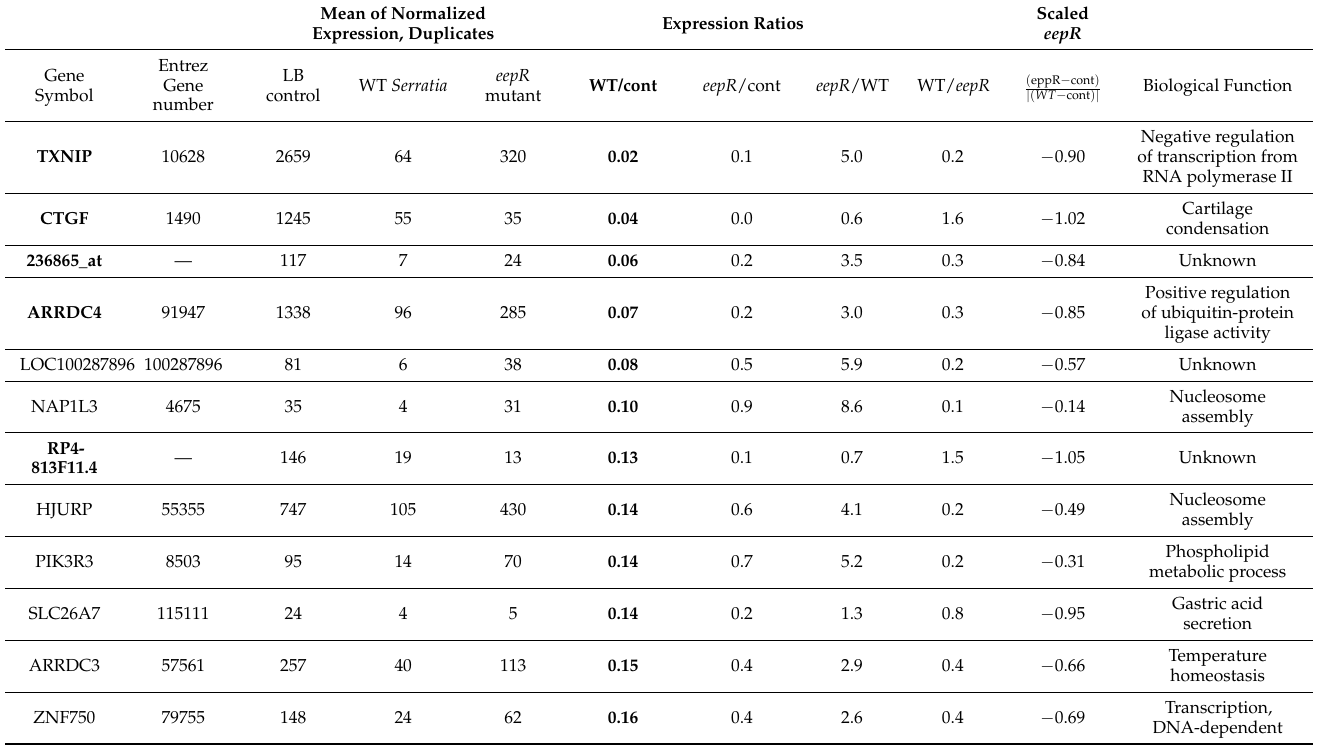
Table 2. Twenty-five genes with the greatest expression decrease in cells treated with WT vs. mock secretomes. Mean of Normalized Expression,